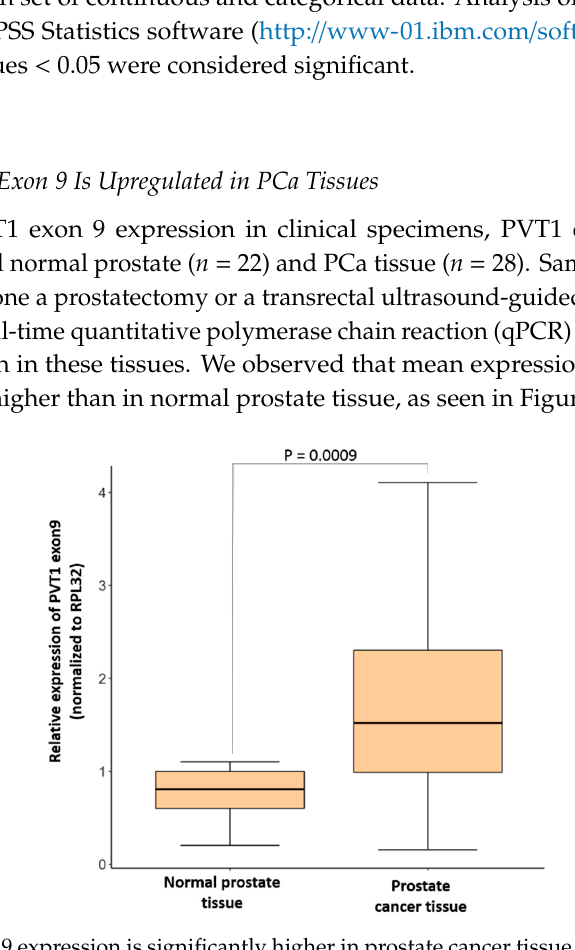
Figure 1. PVT1 exon 9 expression is significantly higher in prostate cancer tissue ( n = 28) in comparison to normal prostate tissues ( n = 22). Data are presented as mean +/ − standard error of the mean (SEM). Statistical differences were determined with one-way ANOVA. All the criteria for significance were set at p < 0.05.